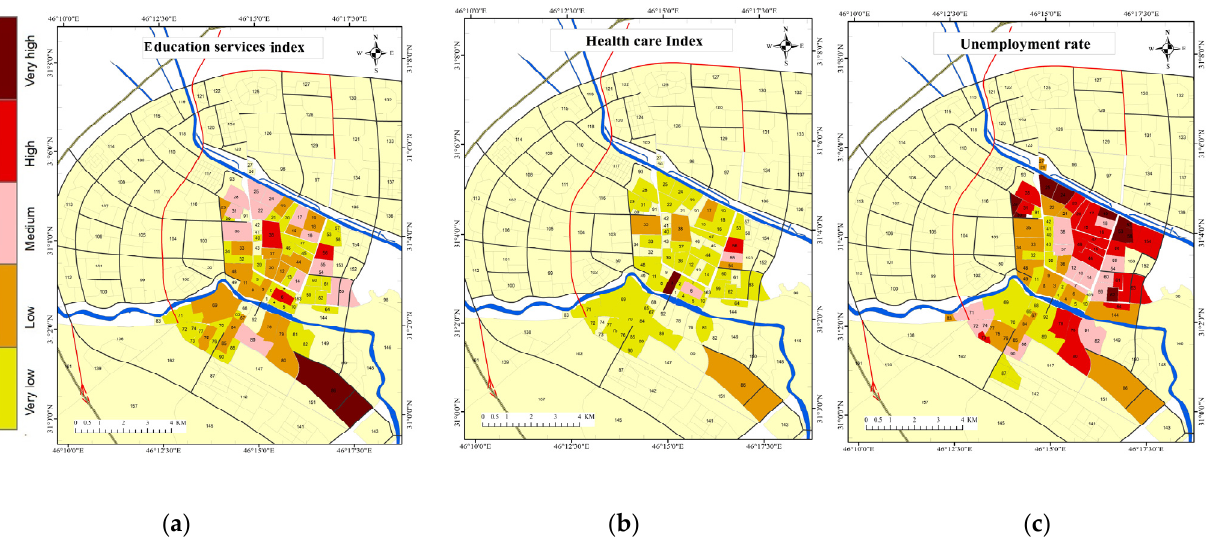
Figure 13. Sub-criteria of the social domain: ( a ) education index (C10), ( b ) health care index (C11) and ( c ) unemployment rate (C12).